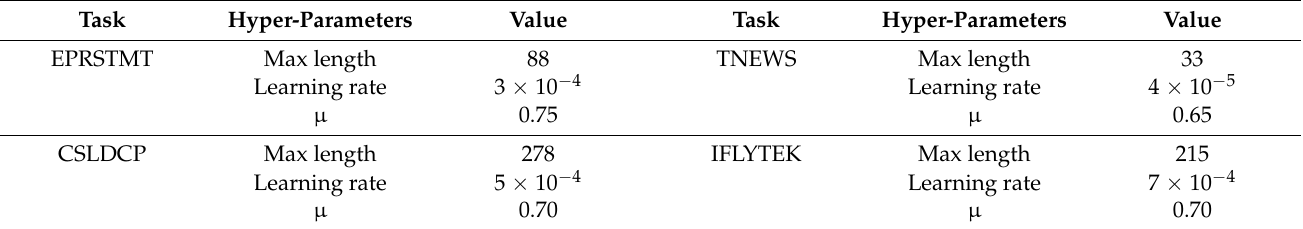
Table 3. Hyper-parameters and their value in our empirical